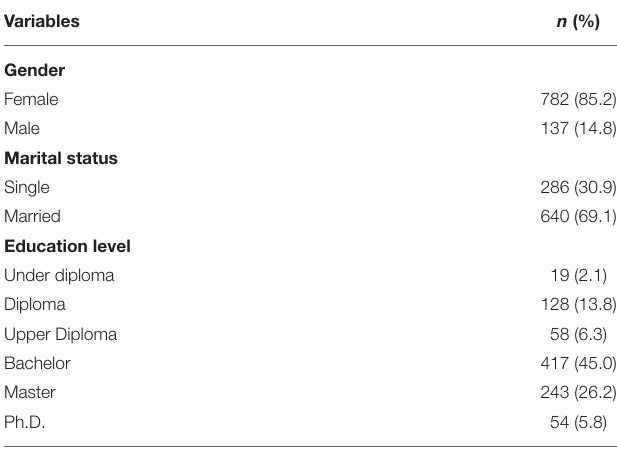
TABLE 1 | Demographic characteristics of participants ( n =